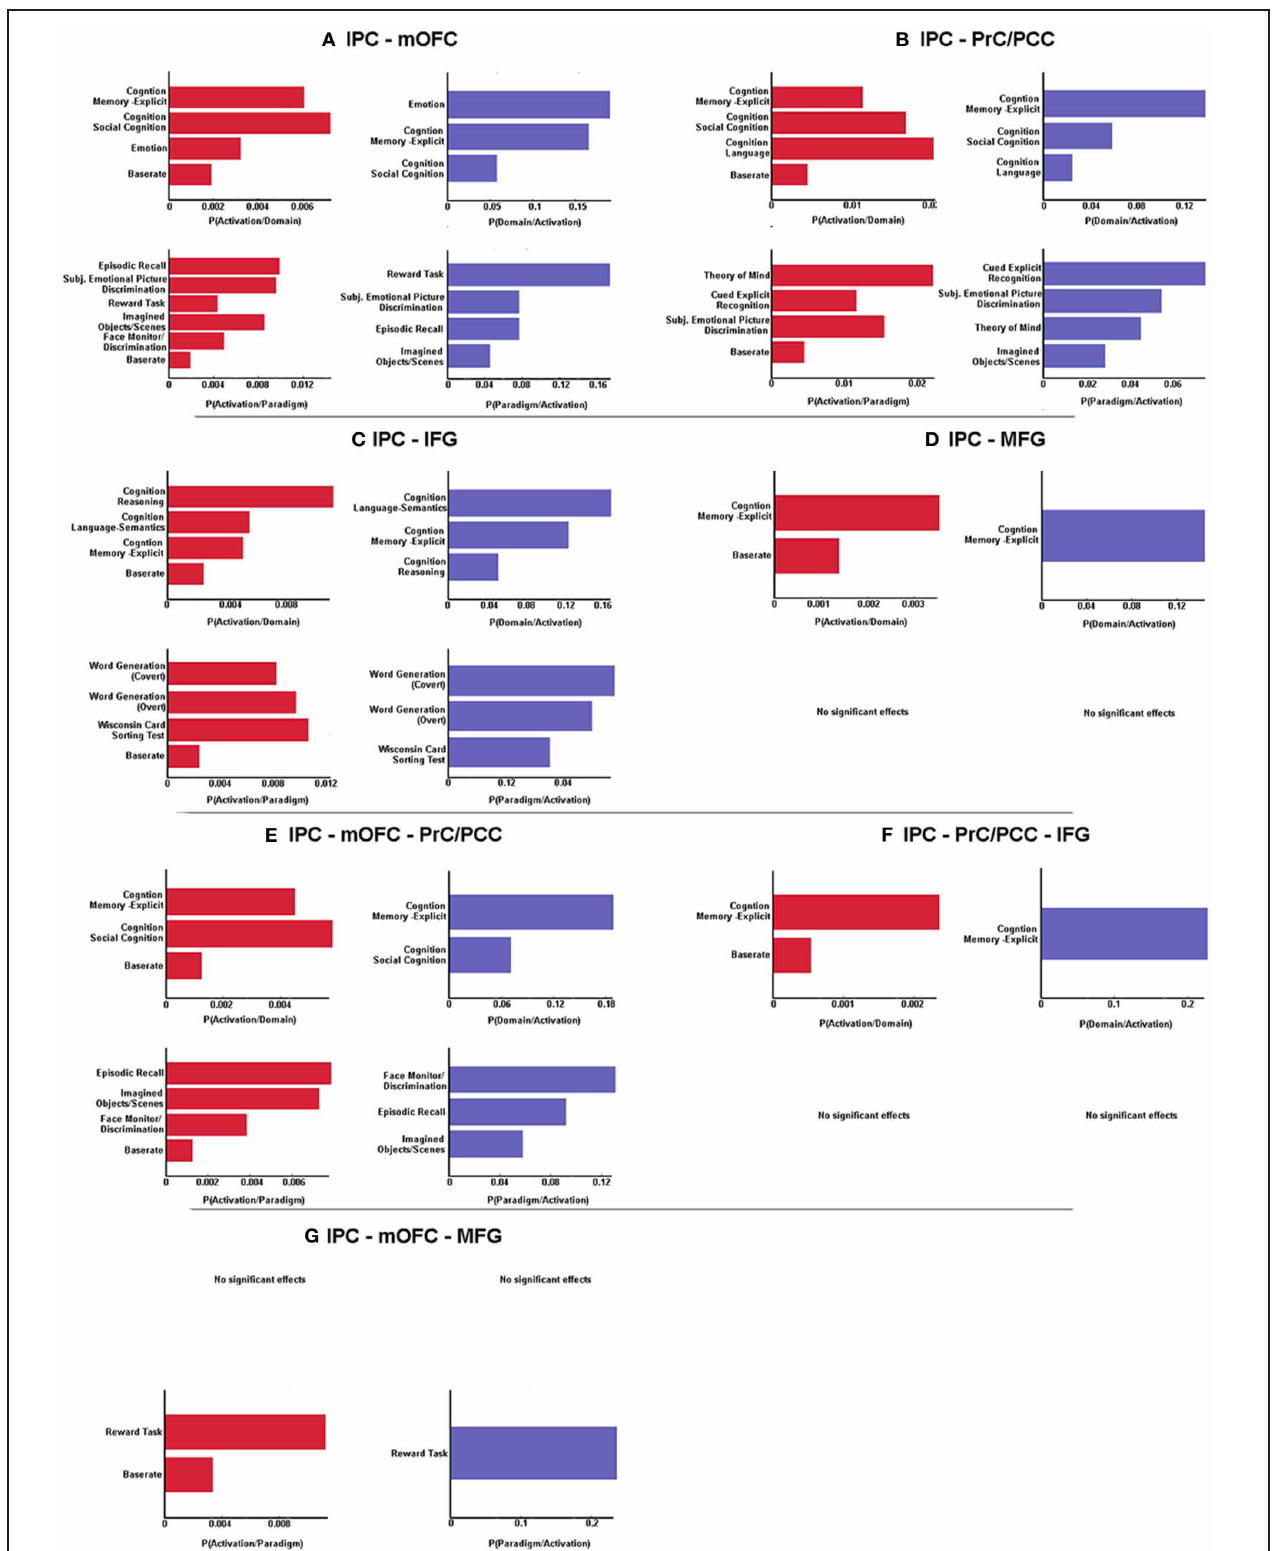
FIGURE 3 | Significant behavioral domains and paradigm classes for the different sub-networks revealed by forward (red) and reverse inference (blue). Details can be found in the result section “Functional characterization of derived networks”.